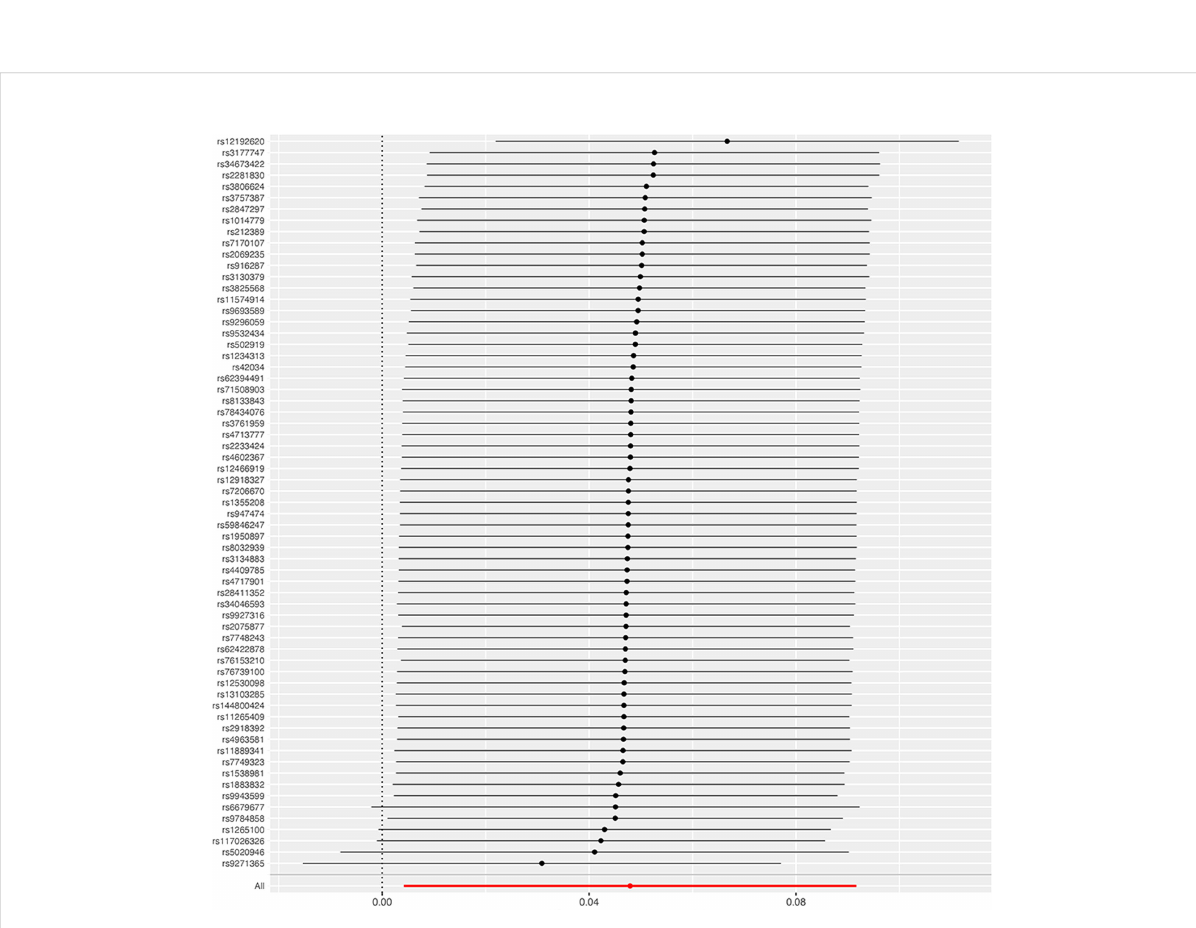
FIGURE 4 Leave-one-out sensitivity analysis of the causal effect of RA on pre-eclampsia. The red line indicates reliable estimations from the IVW and MR Egger methods. RA, rheumatoid arthritis; IVW, inverse variance weighting.